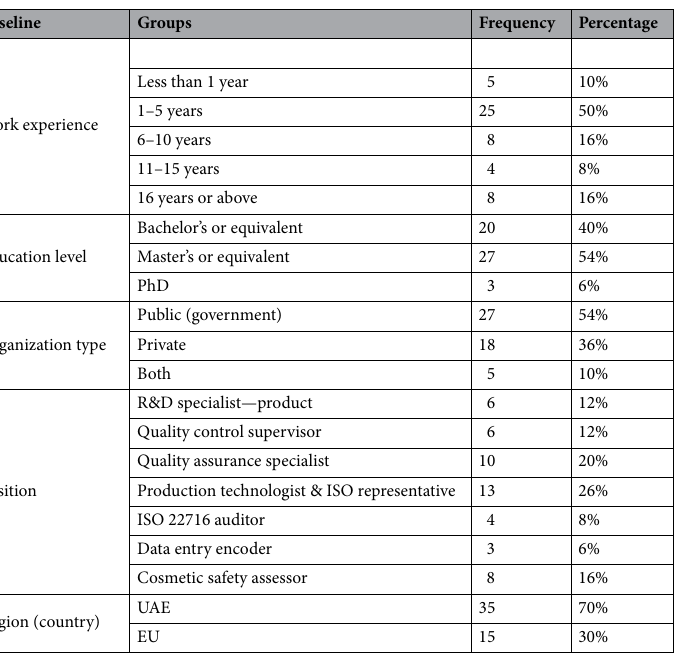
Table 1. Expert panel participants’ baseline characteristics (n = 50). R&D Research and Development, UAE United Arab Emirates, EU European